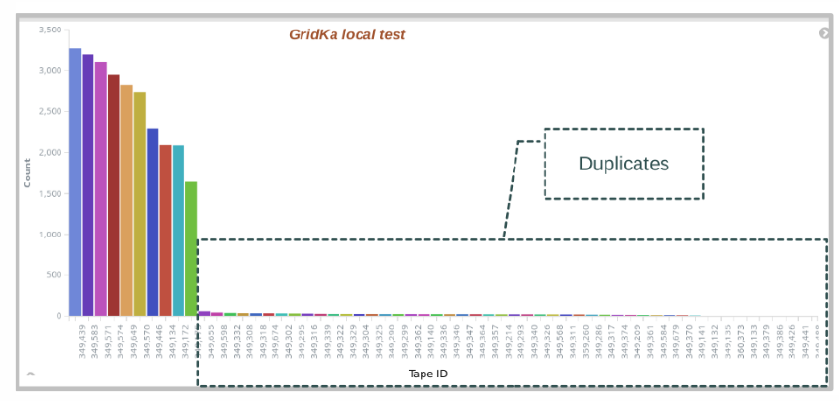
Figure 3: File distribution on di ff erent tapes: Duplicate files on